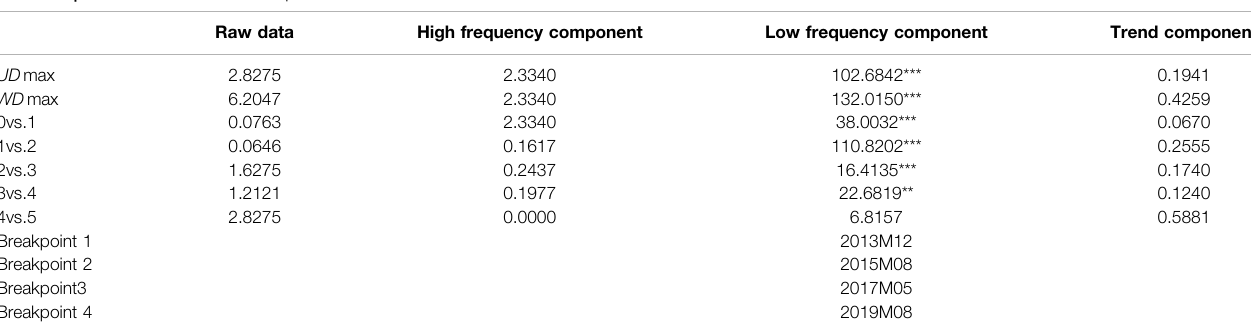
TABLE 4 | Bai-Perron structural breakpoint